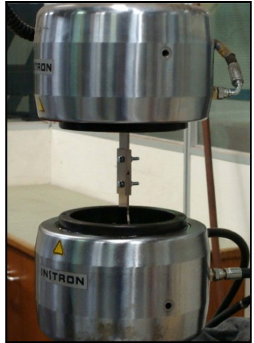
Figure 1. Aluminum alloy 7075-T6 double-lap bolted joint specimen under fatigue